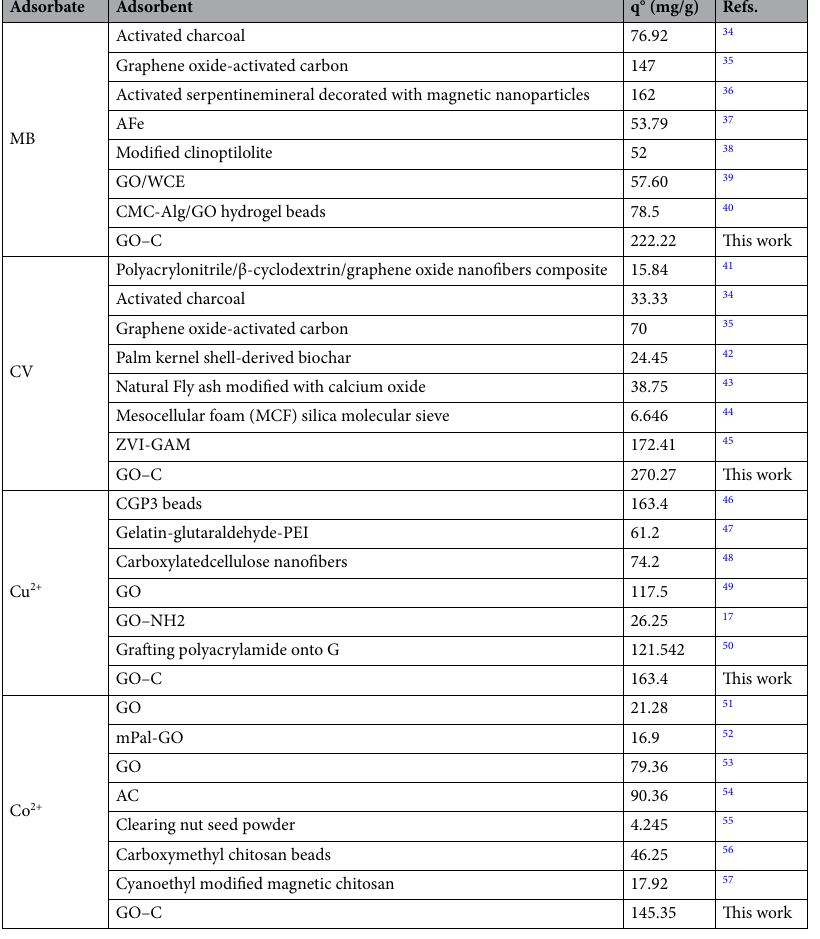
Table 3. Adsorption capacities of various adsorbents of MB, CV, Cu 2+ , Co 2+